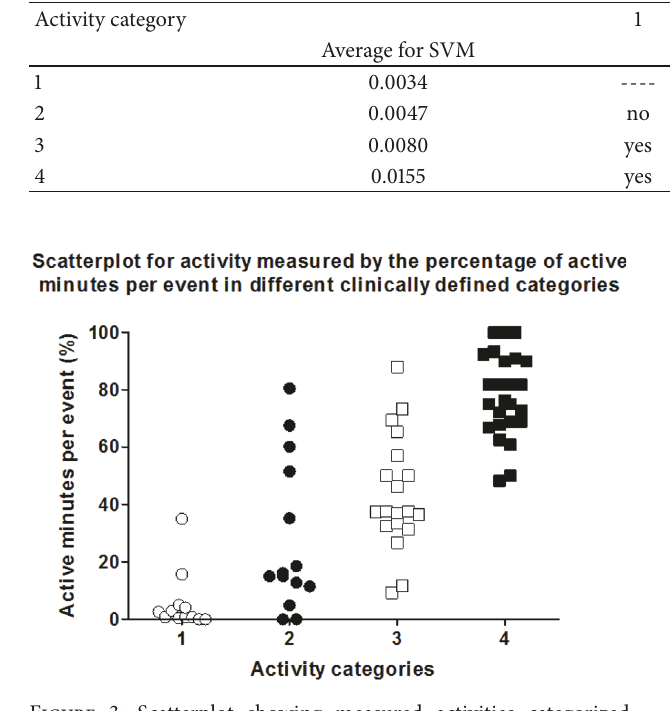
Figure 3: Scatterplot showing measured activities categorized according to clinical activity definitions. The graph represents data, which show percentages of active minutes per event. The decision, whether a minute was active or not, was based on a SVM cut-off calculation.